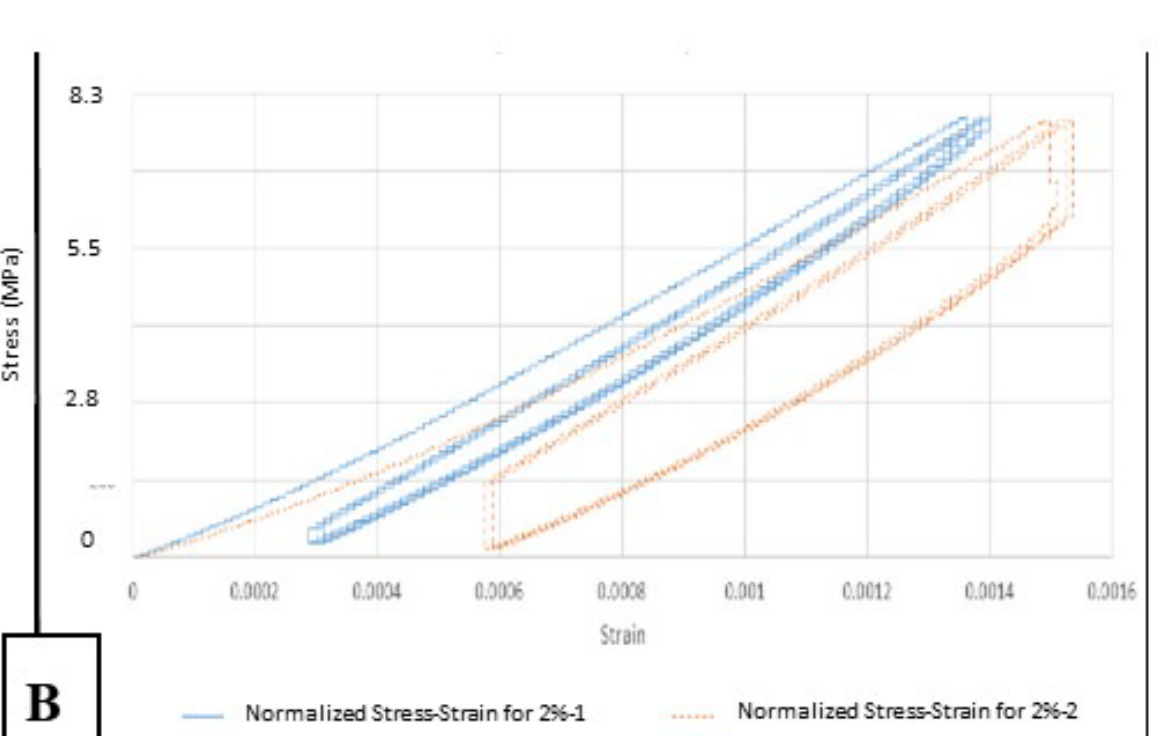
Figure 5. Stress–Strain Curves Showing Multiple Loading Cycles: 0% ( A ) and 2% ( B ) for both Test 1 and Test